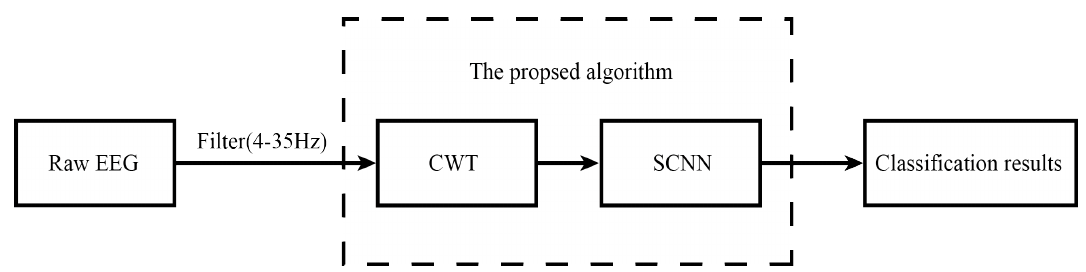
Figure 2. The flowchart of the MI-EEG signal processing in this study. The black arrows represent the flow of signals and the dashed box represents the proposed algorithm. Continuous wavelet transform (CWT) and simplified convolutional neural network